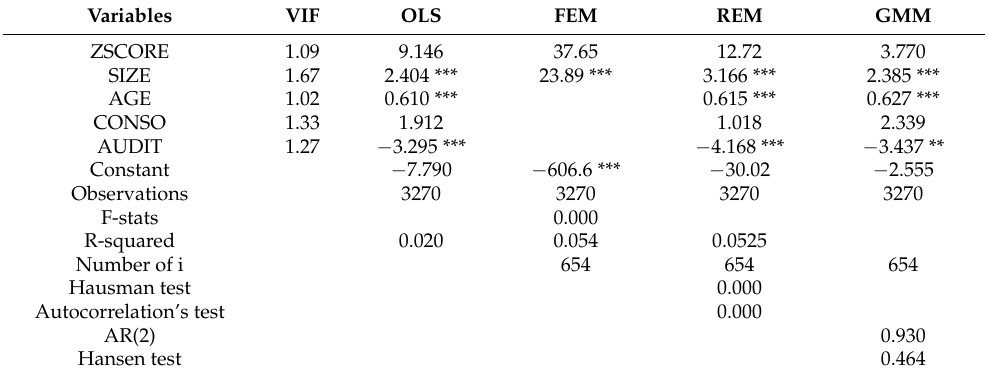
Table 9. Regression results of effects of bankruptcy risk and control variables (firm size, firm age, consolidated report type, auditing firm type) to time of publication annual reports in research model 4.